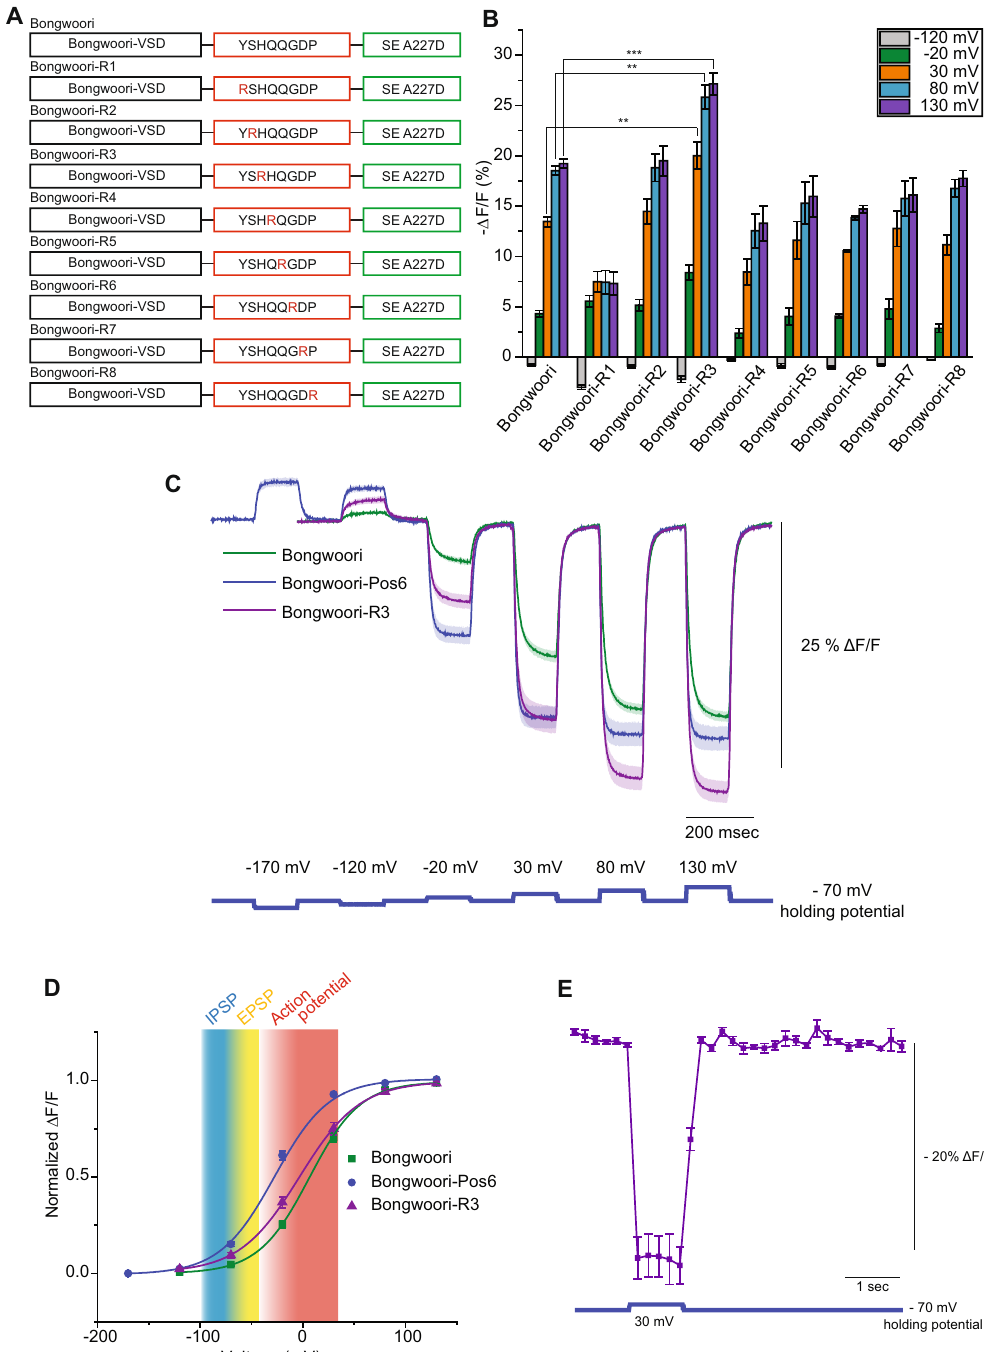
Figure 4. Arginine scanning of the linker domain. ( A ) An arginine residue (red) was introduced at every position between the S4 transmembrane segment and the FP. ( B ) Bar graph of the optical responses for the constructs in A at 5 different membrane potentials. ( C ) Comparison of the optical response of Bongwoori-R3 to Bongwoori and Bongwoori-Pos6. ( D ) The Boltzmann fit of the normalized data in ( C ) Shading is as Fig. 3. The shaded area and error bars denote standard error of the mean. ( E ) Two-photon voltage imaging of Bongwoori-R3 expressing HEK 293 cells responding to a 100 mV depolarizing voltage pulse. The number of HEK 293 cells averaged for each construct; Bongwoori: 4, Bongwoori-R1: 4, Bongwoori-R2: 5, Bongwoori-R3: 5, Bongwoori-R4: 4, Bongwoori-R5: 4, Bongwoori-R6: 4, Bongwoori-R7: 4, Bongwoori-R8: 4 and Bongwoori- Pos6: 4. For two-photon voltage imaging result in ( E ), eight trials were averaged for each cell and the number of cells analyzed was 3. Asterisks in ( B ) indicate statistically significant differences between means compared ( ** p < 0.01 and *** p <